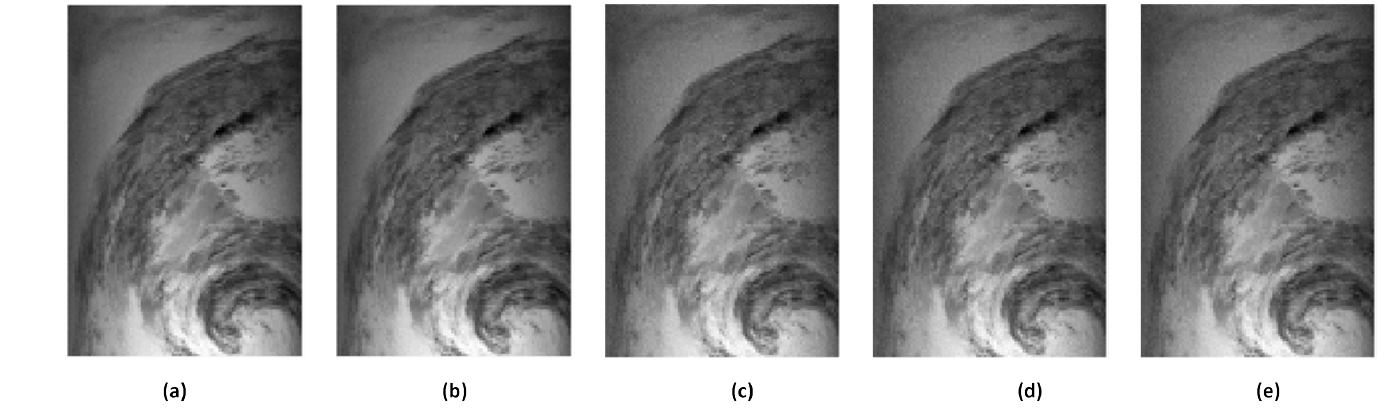
Figure 5. Visual comparison for the “AIRS Grand16 1256th band” image: ( a ) original, ( b – e ) recon- structed image at Λ = { 1,10,20,30 } ,